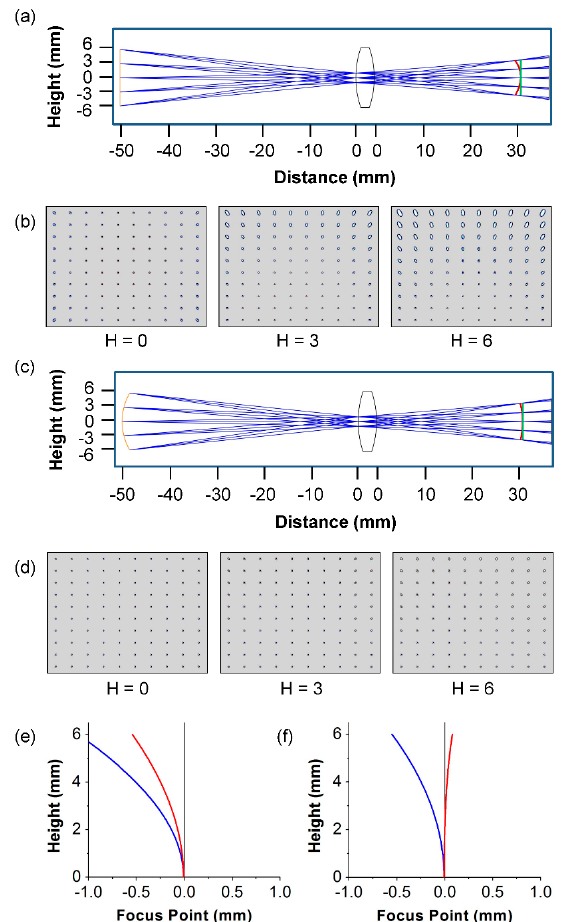
Figure 4. Ray tracing simulation of astigmatism field curvature. Ray tracing of a simple biconvex lens for: ( a ) flat substrate; and ( c ) curved substrate. The grayscale images in ( b , d ) were acquired using the flat and the curved substrates, where the image plane was kept flat. The images in ( b , d ) represent 0, 3, and 6 mm sample substrate height. The field curvature graphs for the flat and the curved substrates are shown in ( e , f ), respectively, where the blue and red lines denote tangential and sagittal surfaces. The designed optical system was simulated by a ray-tracing numerical model using Zemax software. Zemax helps confirm the results of the analytical model and evaluate optical performance over the FOV. The spot diagram, modulation transfer function (MTF), and point spread function (PSF) of the curved substrate show considerably better agreement (Figure 5) than those of the flat substrate. The radius of the Airy disk was 9.87 µ m for both the flat and the curved substrates in the optical system. The RMS radius of the spot diagram in Figure 5a diverges with increasing field height for the flat substrate, but it remains in the Airy disk radius for the curved substrate, as shown in Figure 5d. FOV was used to calculate the MTF. The MTF of this system is plotted for a field point on the optical axis and another point at the edge of the FOV. The field point on the optical axis shows a nearly diffraction-limited response at a spatial frequency of about 120 cycles/mm for the curved substrate in comparison with that for the flat substrate